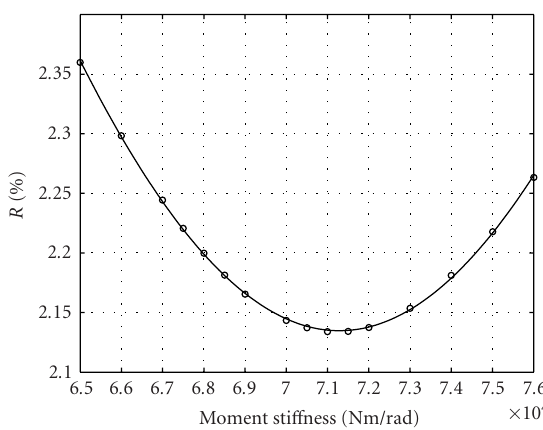
Figure 23: Comparison between the experimental and numerical Campbell diagrams for the configuration B .